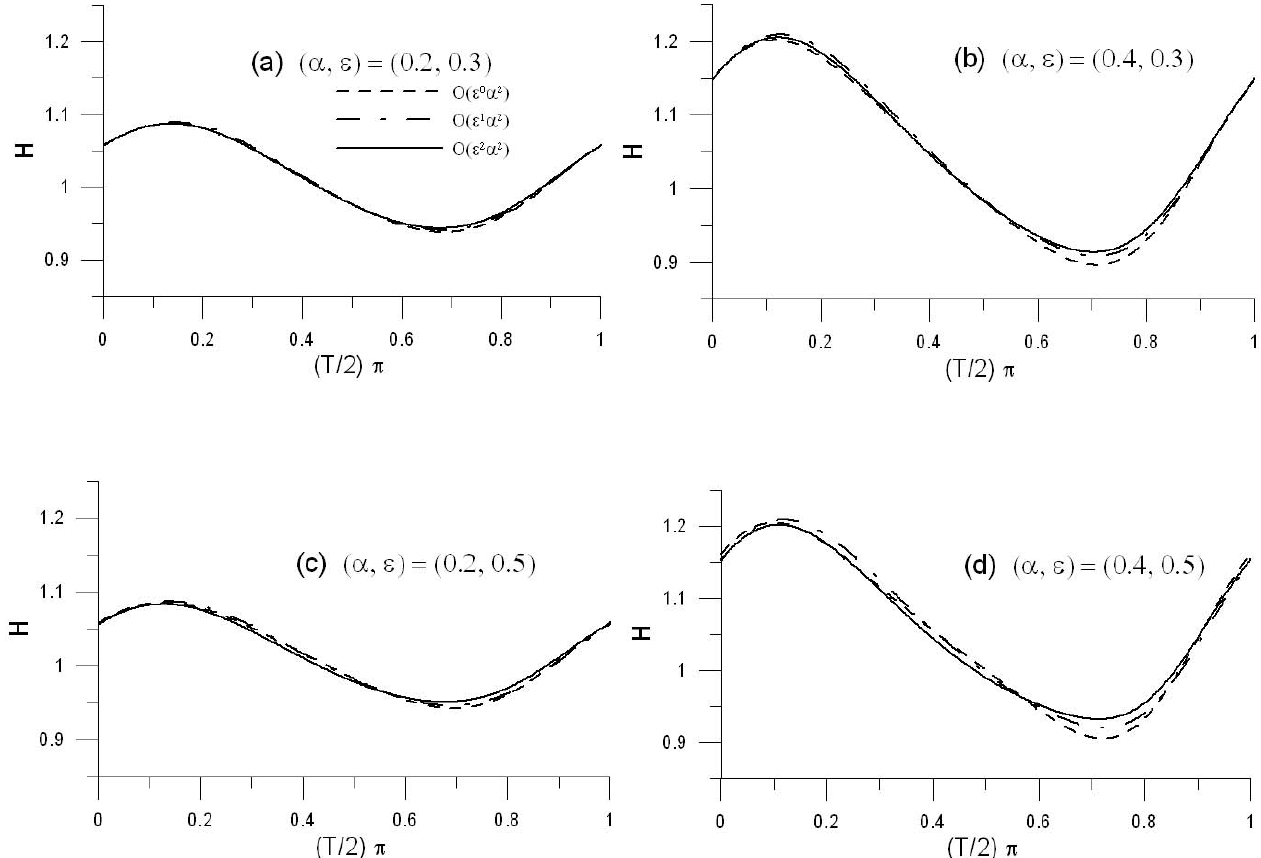
Fig. 2. Distribution of water table level ( H ) versus time ( T/ 2 φ ) in an oceanic island at X = 1 with beach slopes β 1 = β 2 = 45 ◦ .